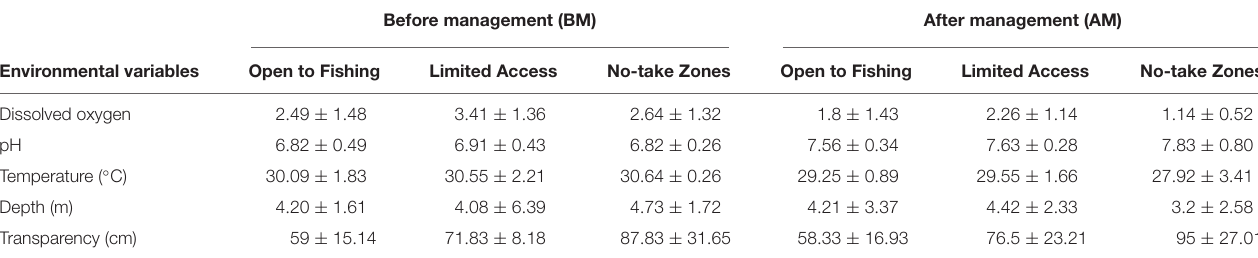
TABLE 2 | The mean (with standard deviation values) of the environmental variables of Paciência Island in the lower Solimões